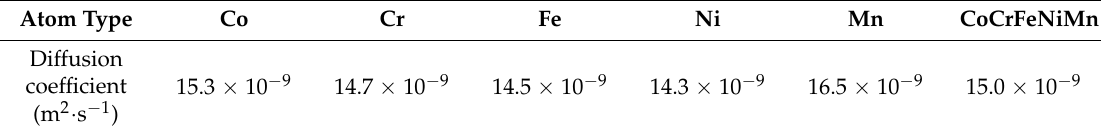
Table 1. The calculated diffusion coefficient for CoCrFeNiMn at 3000 K.